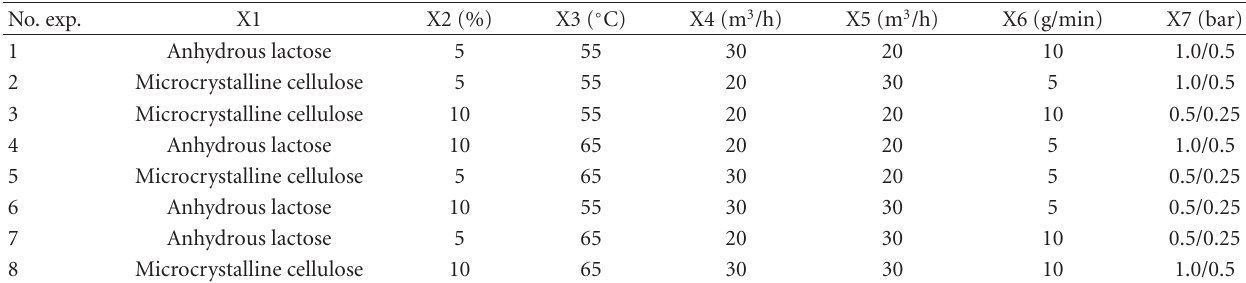
Table 3: Experimental plan for the first set of experiments.